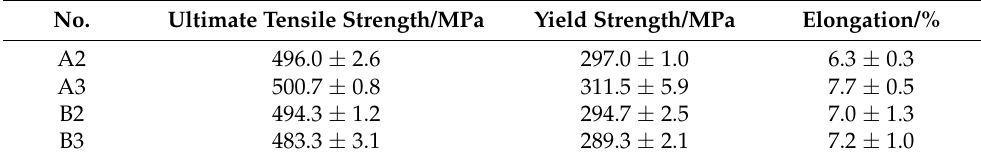
Table 3. Tensile mechanical properties of A2, A3, B2, and B3 samples in the as-printed status.